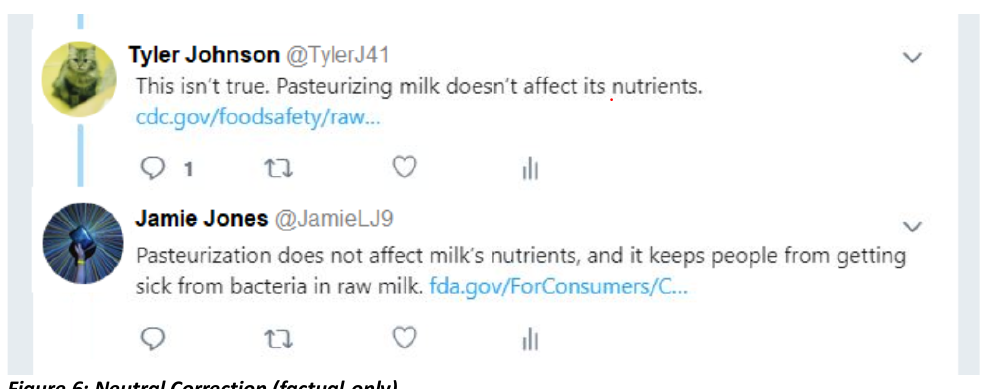
Figure 6: Neutral Correction